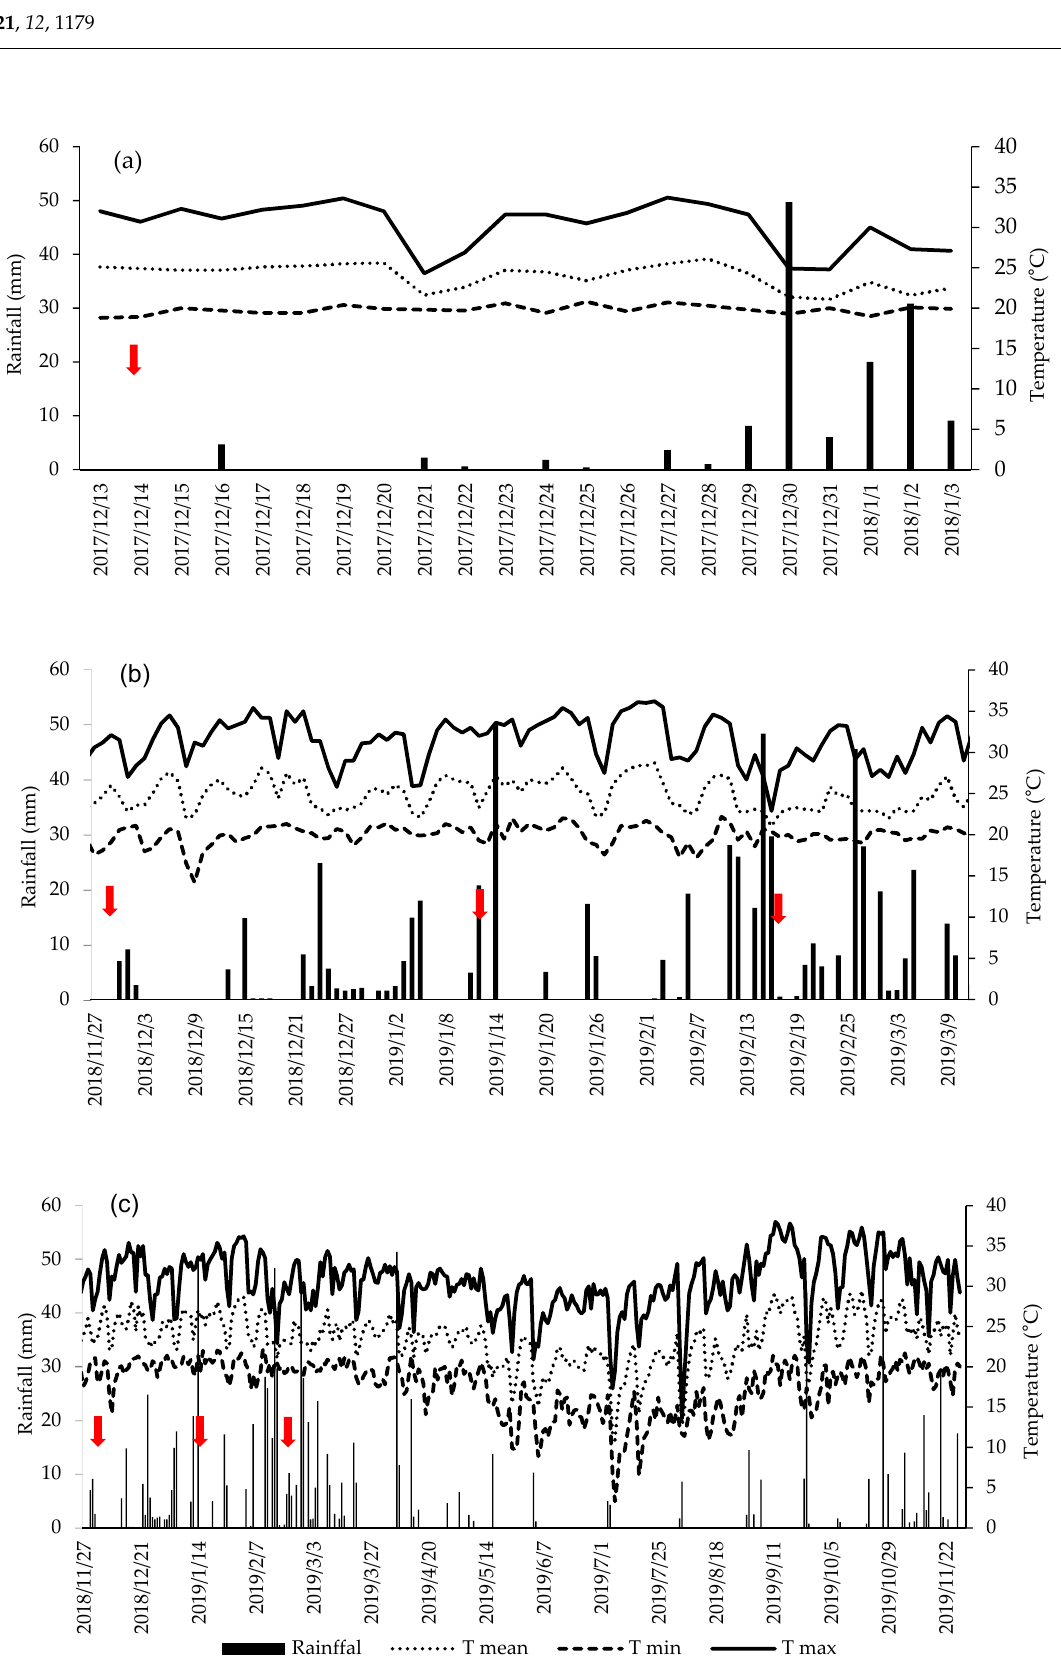
Figure 1. Daily air temperature (minimum, mean, and maximum T; ◦ C) and daily rainfall (R; mm). Data from the Agrome- teorological Station, Department of Exact Sciences, FCAV/UNESP. ( a ) Experiment 1, ( b ) experiment 2, and ( c ) experiment 3. Arrows indicate fertilization